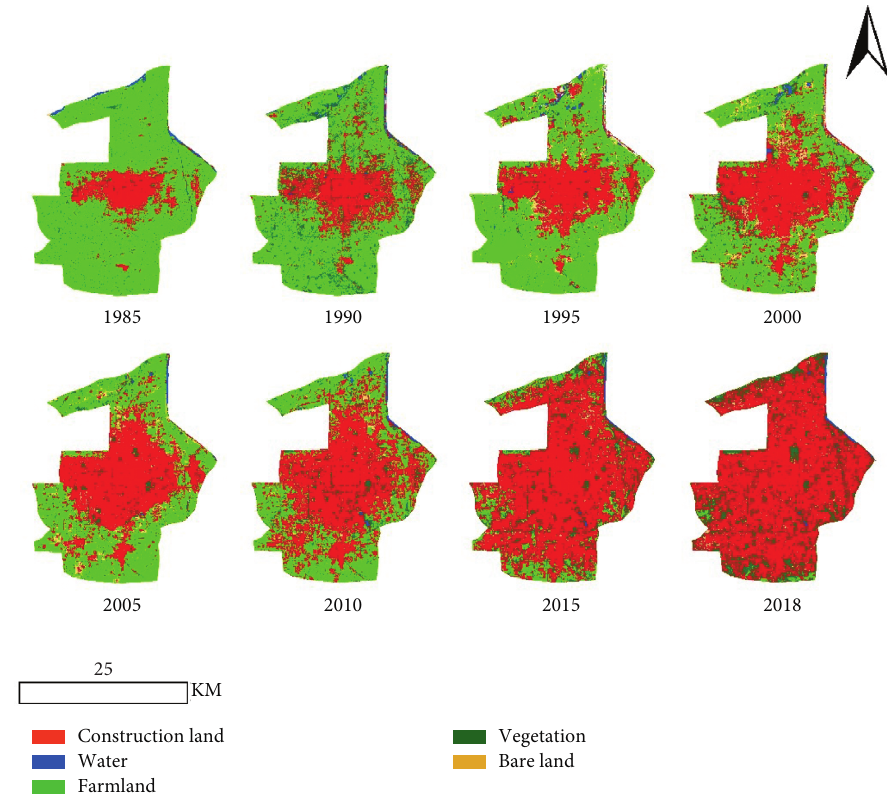
Figure 3: Spatial distribution of land use in the central urban area of the study area from 1984 to 2018.